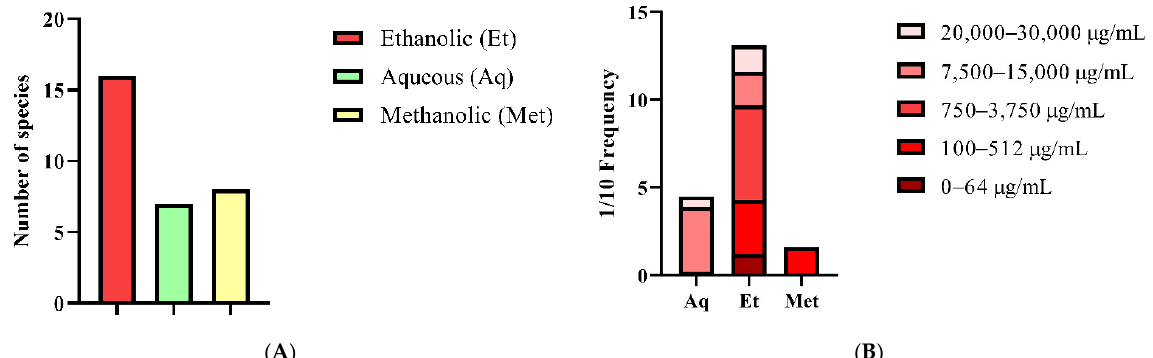
Figure 2. Antimicrobial activity of Brazilian propolis against different microorganisms. ( A ) Several microbial species inhibited by different propolis extracts: Ethanolic (Et) and Supercritical (Sc). ( B ) Distribution of the Minimal Inhibitory Concentrations (MICs) found in the 13 studies evaluated. Frequency: number of MICs found in that interval. EtGP, ScGP, EtRP, ScRP, EtBP and ScBP.